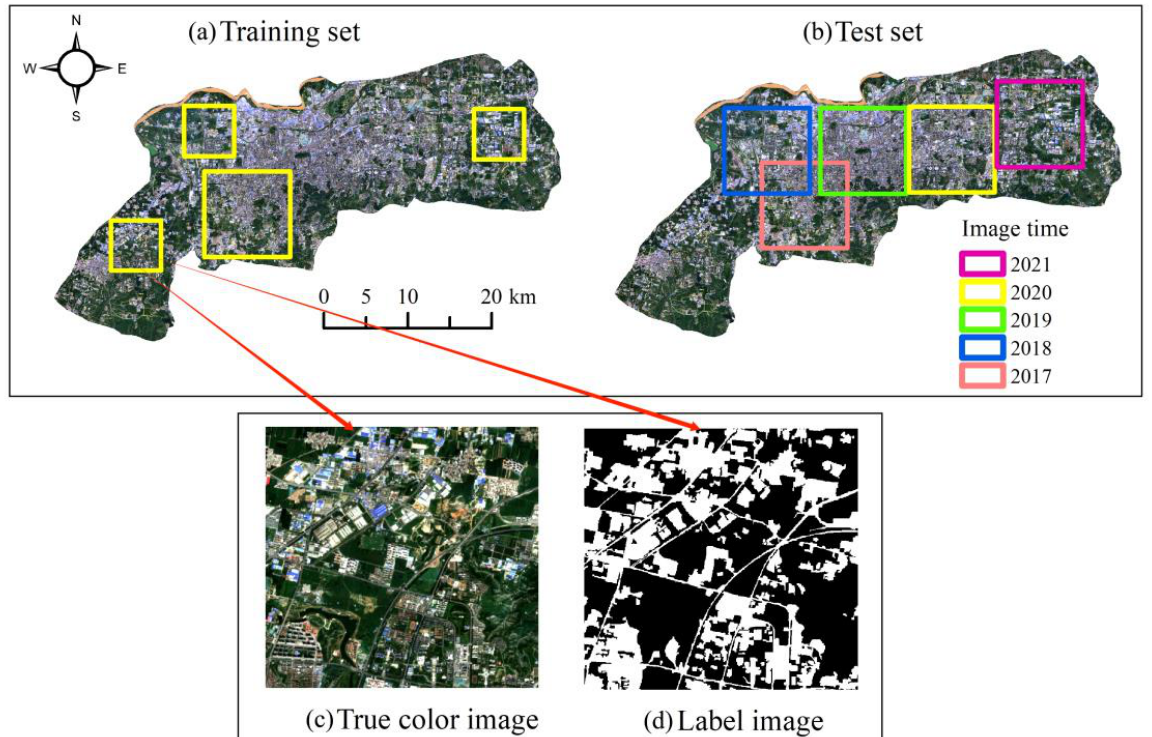
Figure 3. Sample block distribution map and schematic diagram. (a) Training set; (b) Test set; (c) True color image; (d) Label image.